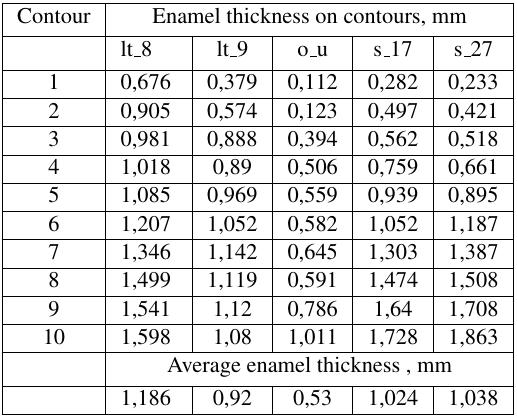
Table 1. Parameters of enamel thickness; individually maximal values are in grey-shaded